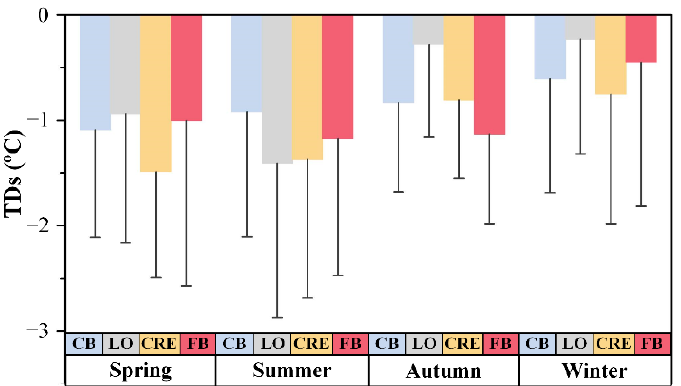
Figure 4. Seasonally mean temperature differences (TDs) and standard deviations (STDs) between ECOSTRESS SST and in situ SST from August 2018 to August 2020. The blue, gray, yellow, and red bars represent CB, LO, CRE, and FB, respectively.